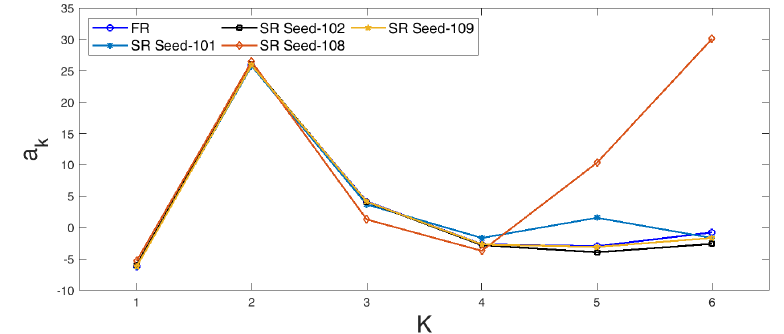
Figure A1. Sparse reconstructed (SR) POD coefficients for different sensor placements compared with full reconstruction (FR) for a given K ∗ = 3.